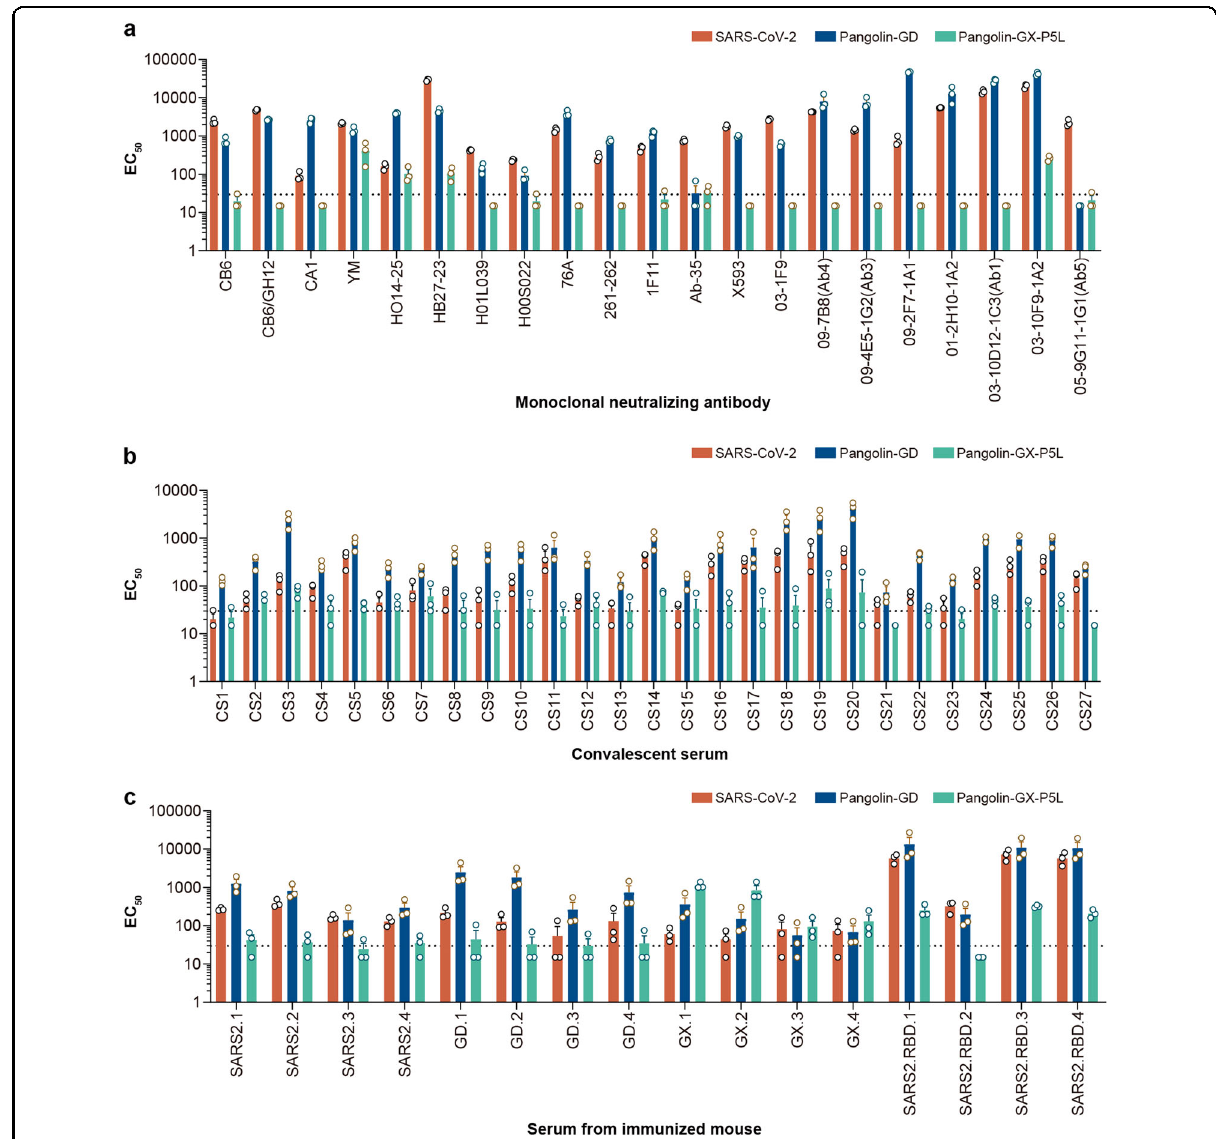
to investigate the cross-reactivity between the three pseudotyped viruses. c S-protein-expressing plasmids for SARS-CoV-2, PCoV-GD, and PCoV-GX were used to immunize animals respectively. SARS2, GD, and GX represent SARS-CoV-2, PCoV-GD, and PCoV-GX, respectively. The numbers showed the animal code; 1 and 2 indicate two serum pools ( fi ve mice for each) from immunized mice, 3 and 4 were designated to two individual serum samples from guinea pigs. Extensive cross-neutralization was observed between SARS-CoV-2 and PCoV-GD, but almost no cross-reactivity between PCoV-GX and